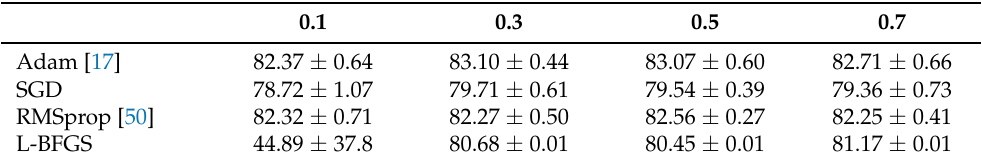
Table 5. The classification accuracy in percentage (mean ± standard deviation) when using different optimization methods. All results are the summary of repeated six